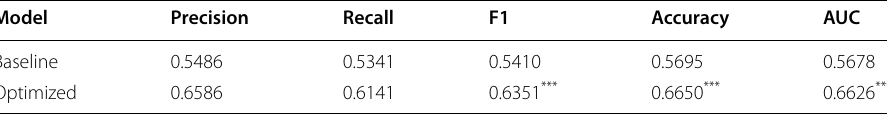
Table 7 Comparison of the evaluation of baseline and optimized model engagement prediction model